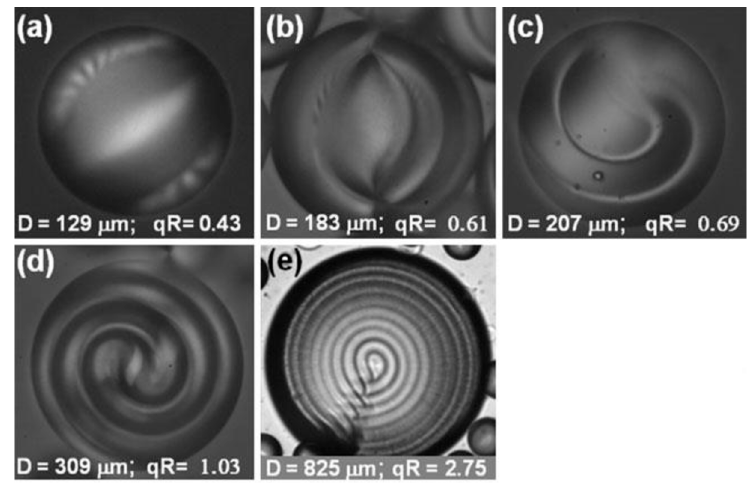
Figure 7. Cholesteric liquid crystal droplets with planar anchoring conditions and different torque power, qR , ordered ascendingly ( a – e ). Reprinted with permission from ref. [36]. Copyright 2011, Springer Nature.